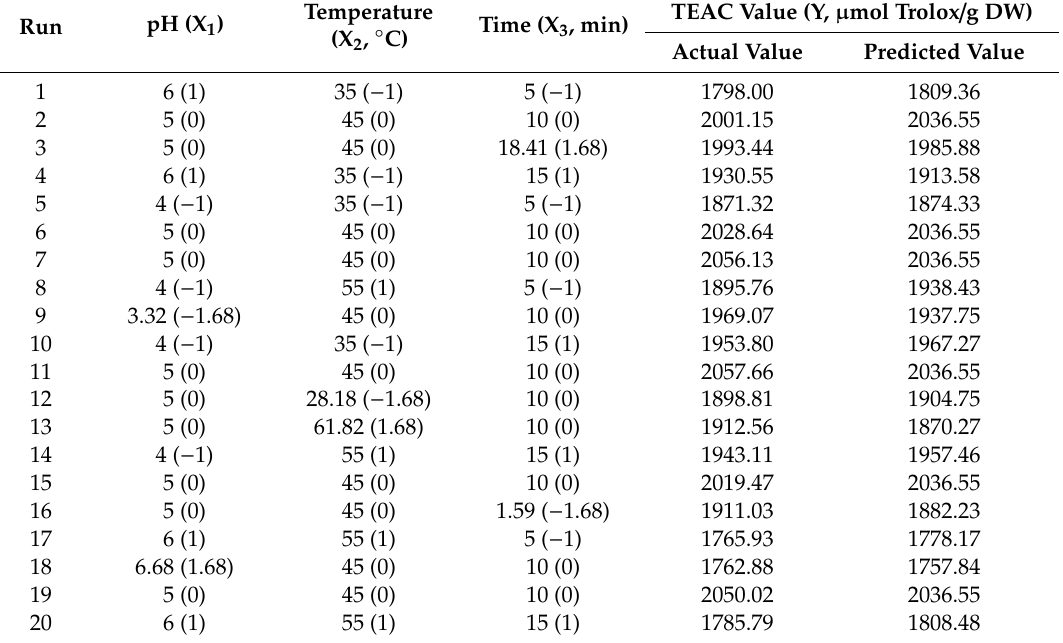
Table 1. Central composite design and result of response surface method